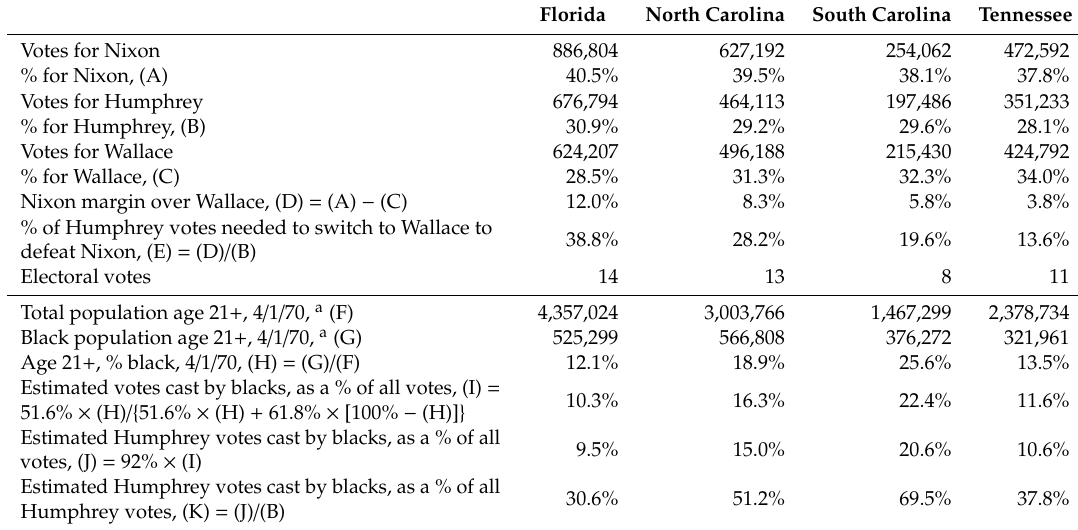
Table 1. Data for four states (1968 election, Scenario